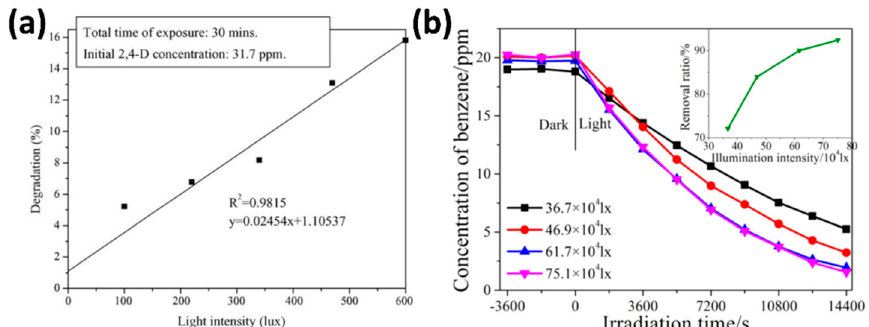
Figure 10. Effect of light intensity on the photodegradation of ( a ) 2,4-D with low light intensity (100–600 lx) (reproduced with permission from [73] . Copyright Elsevier Science Publishers, 2005.), and ( b ) benzene with high light intensity (36.7 × 10 4 –75.1 × 10 4 lx) (reproduced with permission from [74] . Copyright MDPI, 2018.).